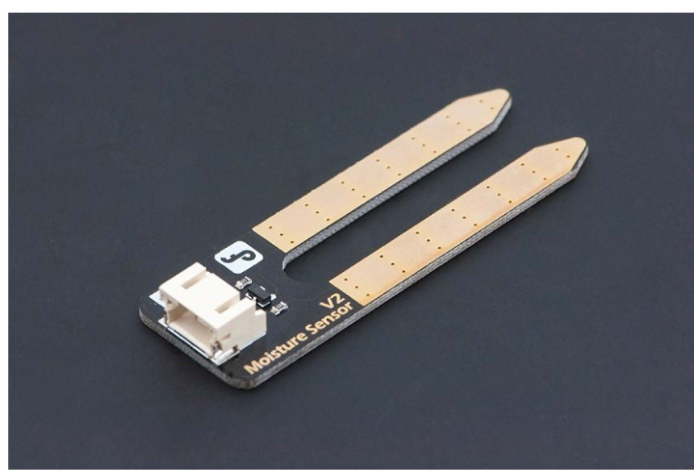
Figure 2. DFRobot Soil Moisture Sensor (Arduino Compatible) Immersion Gold.